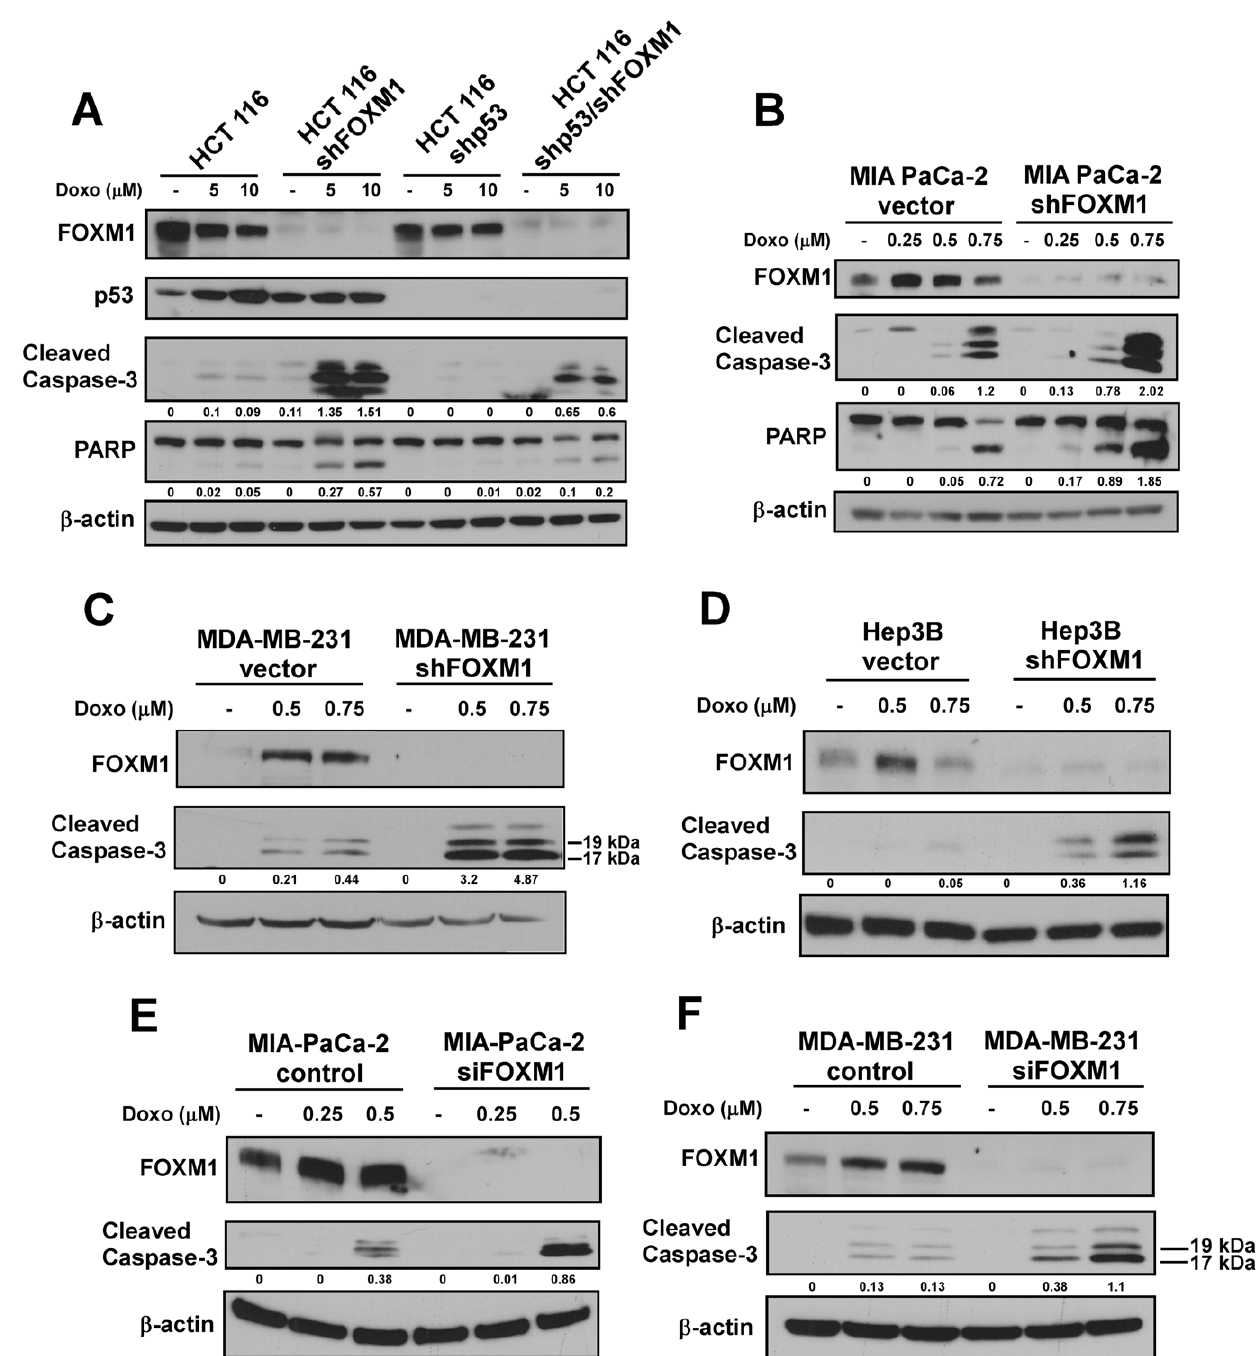
Figure 1. Suppression of FOXM1 by RNAi sensitizes human cancer cells to doxorubicin. ( A ) HCT 116 p53 proficient and deficient human colon cancer cells with FOXM1 knockdown were treated with doxorubicin (Doxo) as indicated. Immunoblotting for FOXM1, p53, cleaved caspase-3, PARP and b -actin as the loading control was carried out 24 hours after treatment. ( B ) MIA PaCa-2 vector control and FOXM1 knockdown pancreatic cancer cells were treated with the indicated concentrations of doxorubicin. Twenty-four hours after treatment cell lysates were immunoblotted for FOXM1, cleaved caspase-3, PARP and b -actin as the loading control. ( C ) MDA-MB-231 vector control and FOXM1 knockdown breast cancer cells were treated with doxorubicin as indicated. Immunoblot analysis was performed for FOXM1, cleaved caspase-3 and b -actin as the loading control 48 hours after treatment. ( D ) Hep3B vector control and FOXM1 knockdown liver cancer cells were treated with the indicated concentrations of doxorubicin. Cell lysates were immunoblotted for FOXM1, cleaved caspase-3 and b -actin as the loading control 24 hours after treatment. ( E ) Pancreatic cancer cells MIA PaCa-2 were transfected with control and FOXM1 siRNA for 48 hours, and then treated as indicated. Twenty-four hours after treatment immunoblotting was carried out with FOXM1, cleaved caspase-3 and b -actin antibodies. ( F ) Breast cancer cells MDA-MB-231 were transfected with control and FOXM1 siRNA for 48 hours, then treated with the indicated concentrations of doxorubicin. Forty-eight hours after treatment cell lysates were immunoblotted for FOXM1, cleaved caspase-3 and b -actin as the loading control.